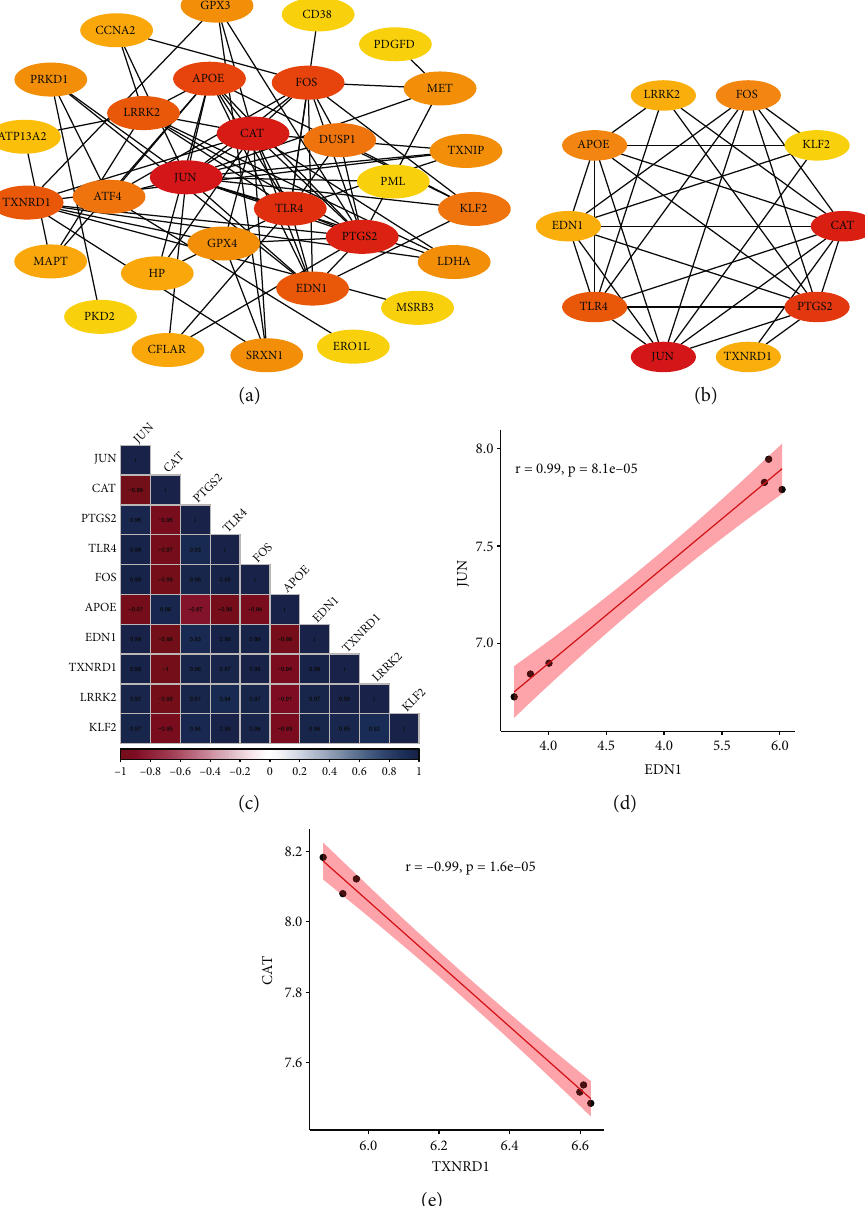
Figure 4: PPI analysis of OSRDEGs. (a) PPI analysis; (b) Top 10 hub OSRDEGs; (c) Correlation analysis among 10 hub OSRDEGs; (d) Correlation analysis between JUN and EDN1; (e) Correlation analysis between CAT and